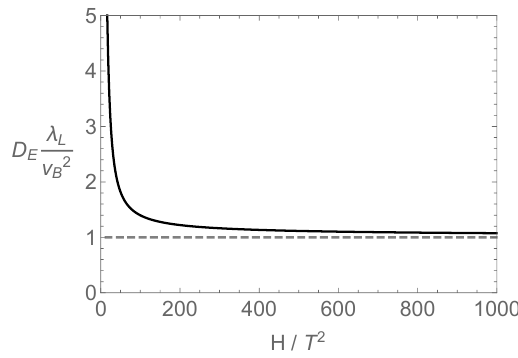
Figure 9 . The diffusion bounds of D E (4.25) with magnetic fields. λ L = 2 πT , the butterfly velocity v B is (3.6). The dashed line denotes the lower bound